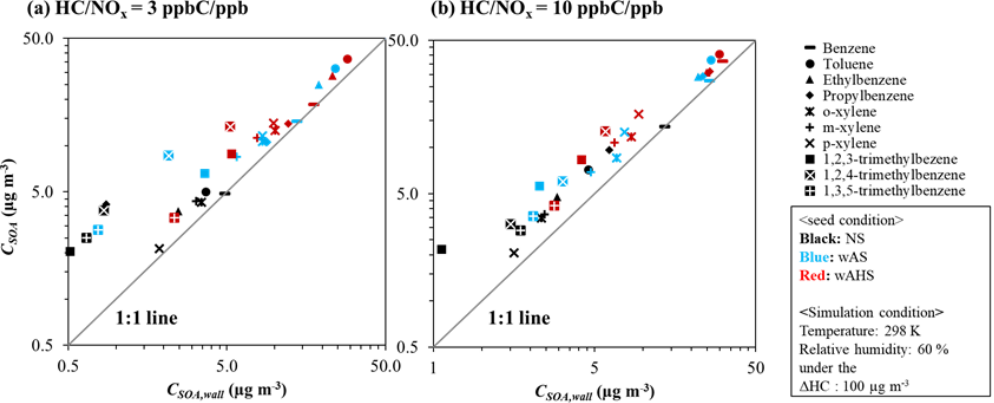
Figure 3. The simulated C SOA and C SOA , wall for 10 different aromatic HCs at the given reference conditions. The SOA formation is simulated at the 298K and 60% at a given sunlight intensity (Fig. S5a). The concentration of initial HC is determined to consume 100µgm − 3 of HC at 17:00EST. The initial HC ppbC/NO x ppb sets to 3 and 10 for high NO x level and low NO x level, respectively. SOA masses are also obtained at 17:00EST. The color of the symbol indicates the seed conditions: black, blue, and red for non-seeded (NS), wet ammonium sulfate (wAS), and wet ammonium hydrogen sulfate (wAHS),